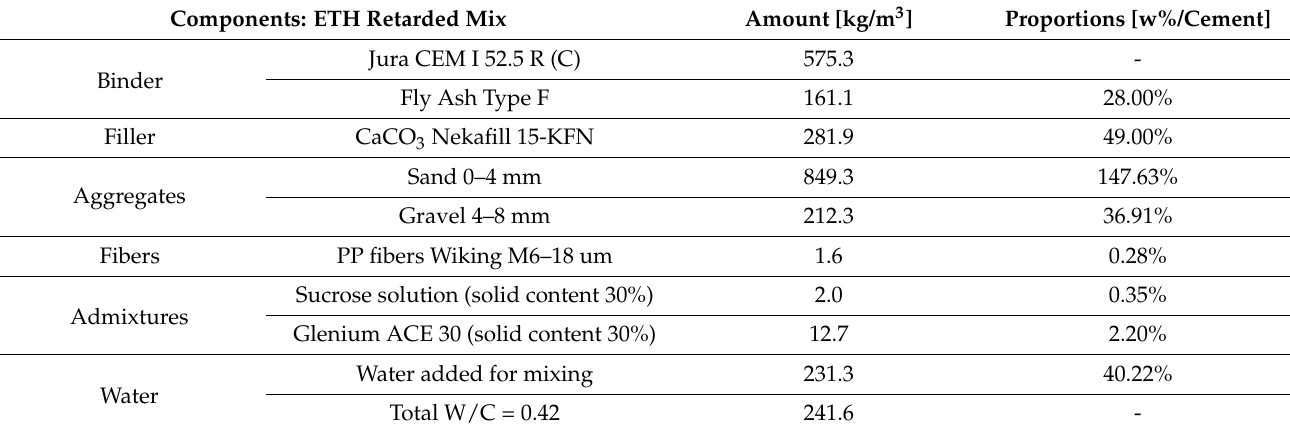
Table 1. Recipe for the ETH retarded (base) mix.